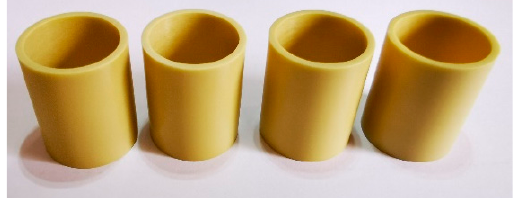
Figure 2. The samples of PZT-52 tube actuator.